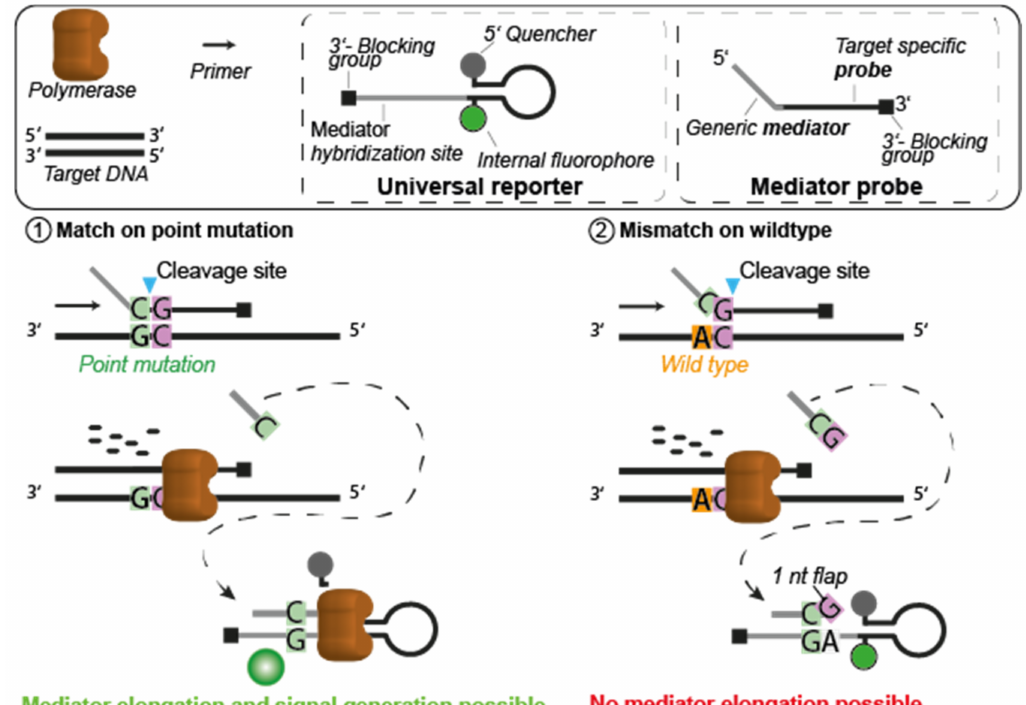
Figure 1. Principle for point mutation detection by MP PCR. The MP comprises a target specific probe and a generic mediator. During primer elongation, the mediator is cleaved by the polymerase and diffuses to the signal generating molecule, the UR oligonucleotide. There, the mediator can hybridize to the reverse complementary sequence of the UR. The mediator is elongated if its 3 (cid:48) end is bound to the UR sequence. Because of the elongation, a fluorescence signal is generated by either cleavage of the fluorophore and quencher or by unfolding of the hairpin structure of the UR. Case 1 shows the matching of the MP at the point mutation to be detected (green; G). The mediator is cleaved precisely after the position of the point mutation and thus the 3 (cid:48) end of the mediator can be elongated at the UR leading to signal generation. In case 2, MP mismatch at the position of the targeted point mutation (orange; A) shifts the cleavage by exactly one nucleotide (purple; G). The UR is designed so that this nucleotide (nt) forms a so-called 1 nt flap, leading to an unbound 3 (cid:48) end of the mediator when it hybridizes to the UR. This protruding nucleotide (G) prevents the mediator from being elongated and suppresses signal